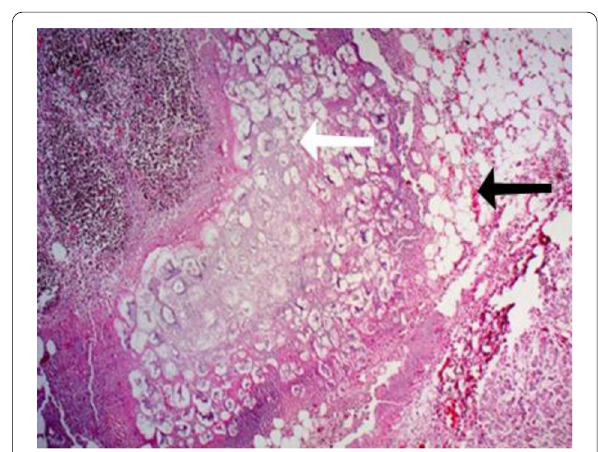
Fig. 3 Microphotograph of the pancreas H & E ( hemorrhage indicated with a black arrow, fat necrosis indicated with a white arrow, and